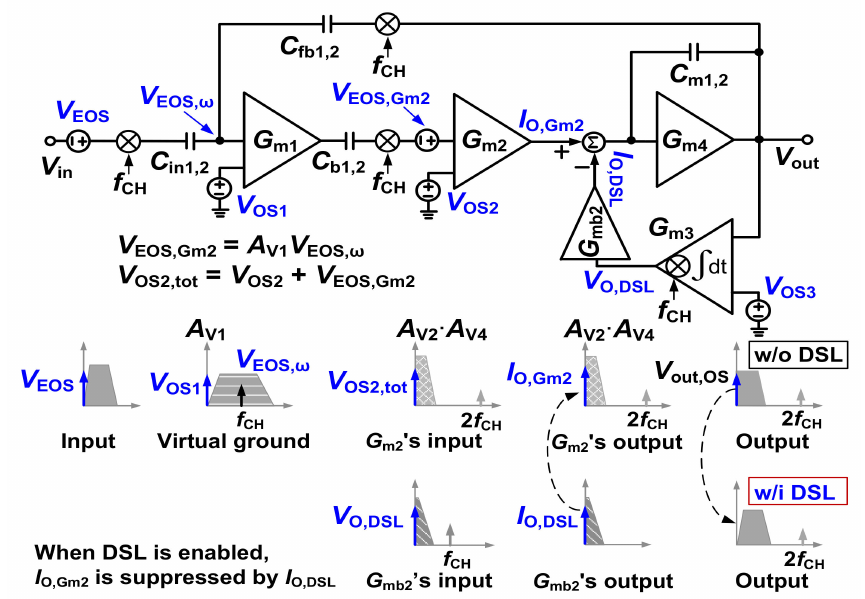
Figure 2. A simplified model of the proposed CCIA.